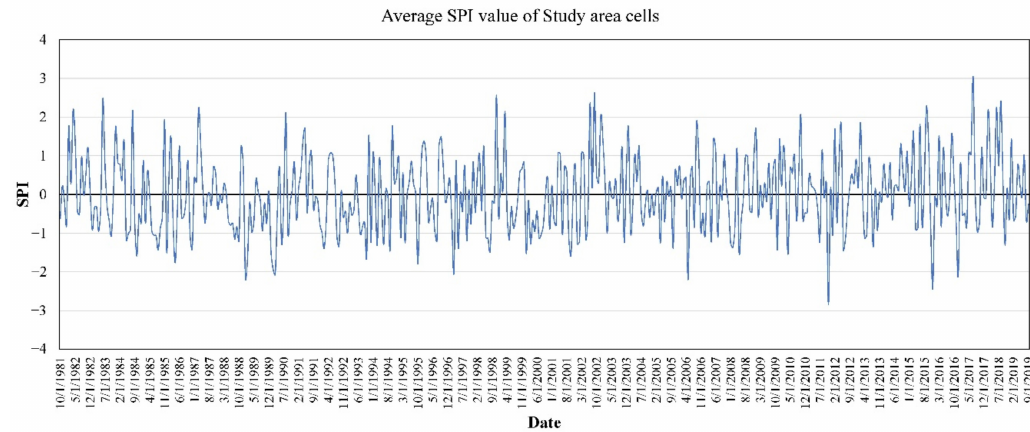
Figure 3. The average value of SPI of the 63 cells located in the study area for the last thirty-eight